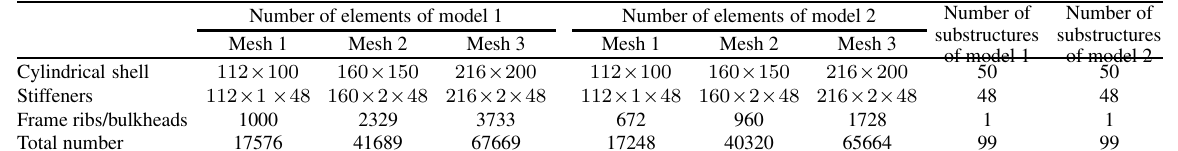
Table 2 FEM models with different meshes and substructure divisions of WBM